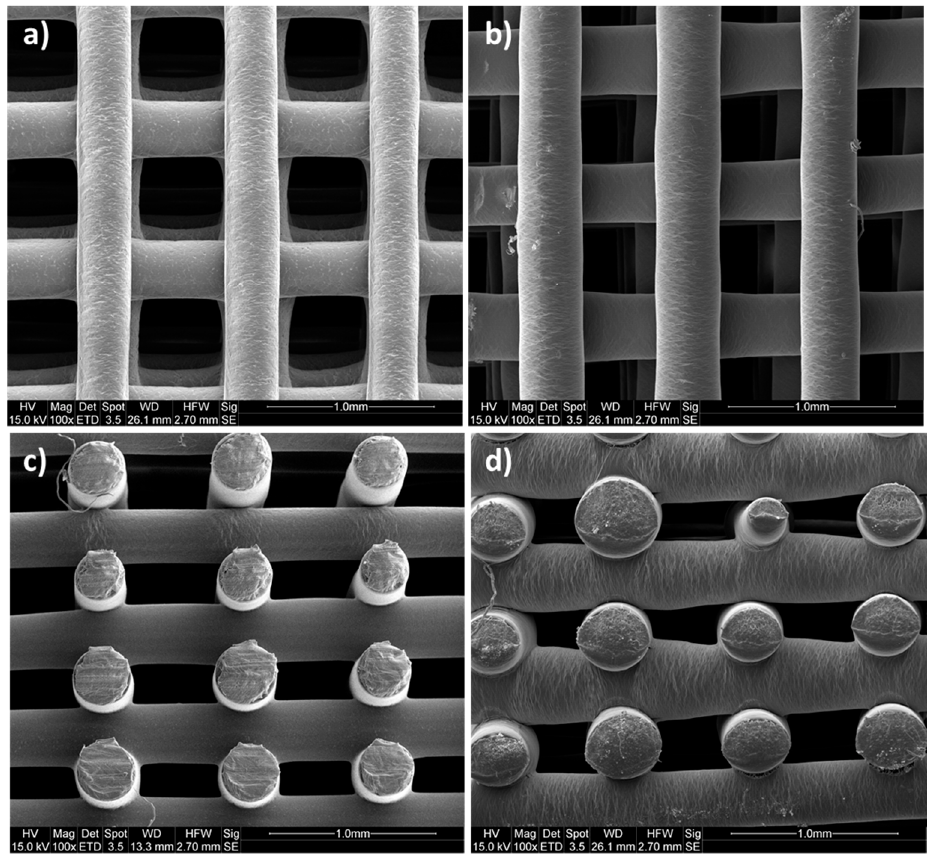
Figure 3. SEM micrographs of 3D printed scaffolds. ( a ) PCL scaffold top view; ( b ) PEU scaffold top view; ( c ) PCL scaffold cross-sectional view; ( d ) PEU scaffold cross-sectional view.